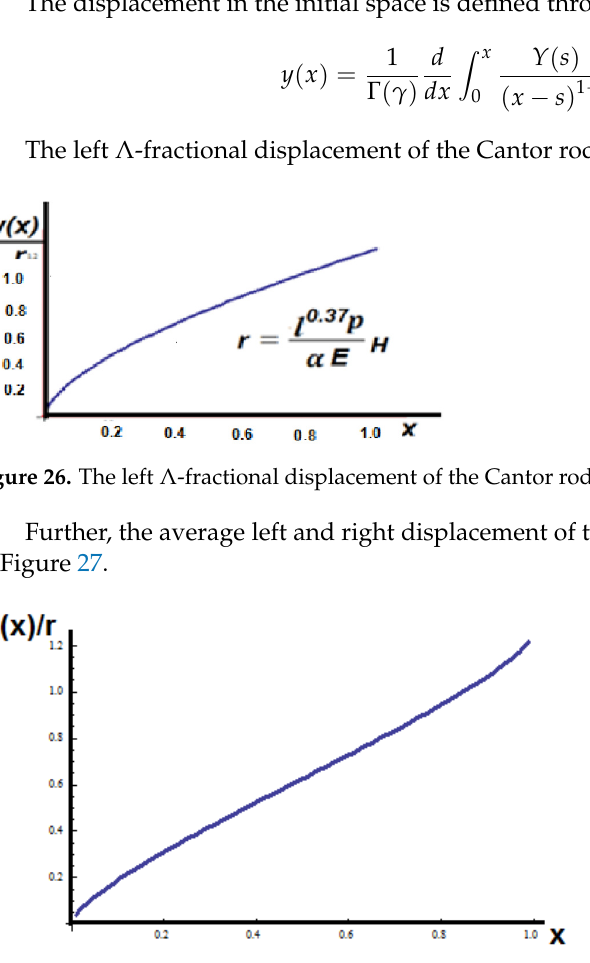
Figure 27. The average left and right Λ -fractional displacement of the Cantor rod in the initial space. The present section introduces the fractional deformation of a body with horizon. The present theory may be transferred into fractional deformation problems with